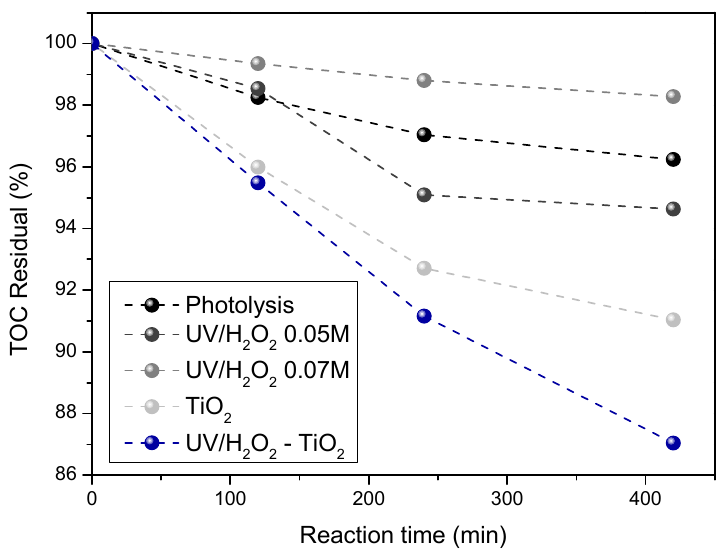
Figure 5. TOC evolution as a function of the reaction time under different AOPs.